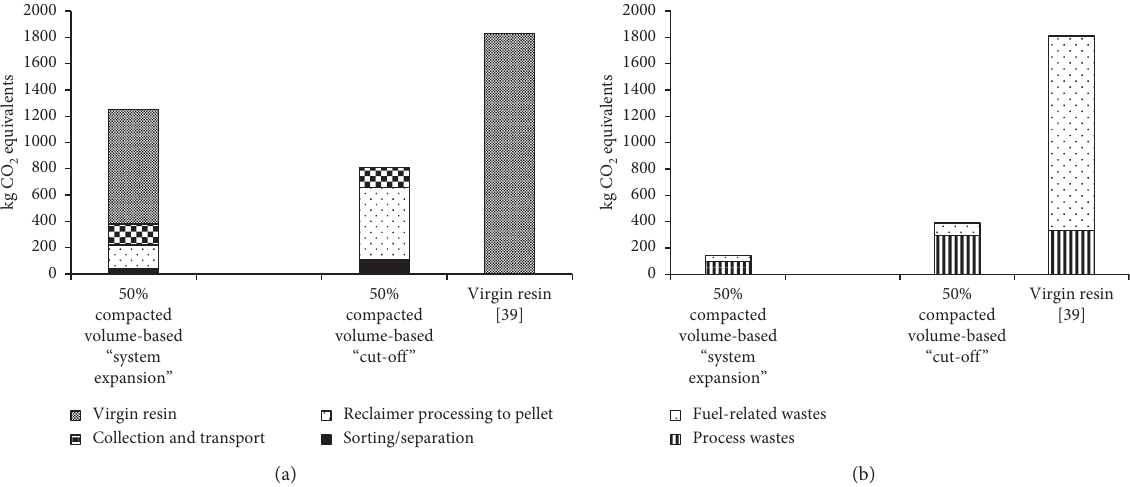
Figure 4: Greenhouse gas results for production of the recycled PET resin flake (kg CO stage and (b) emission category.